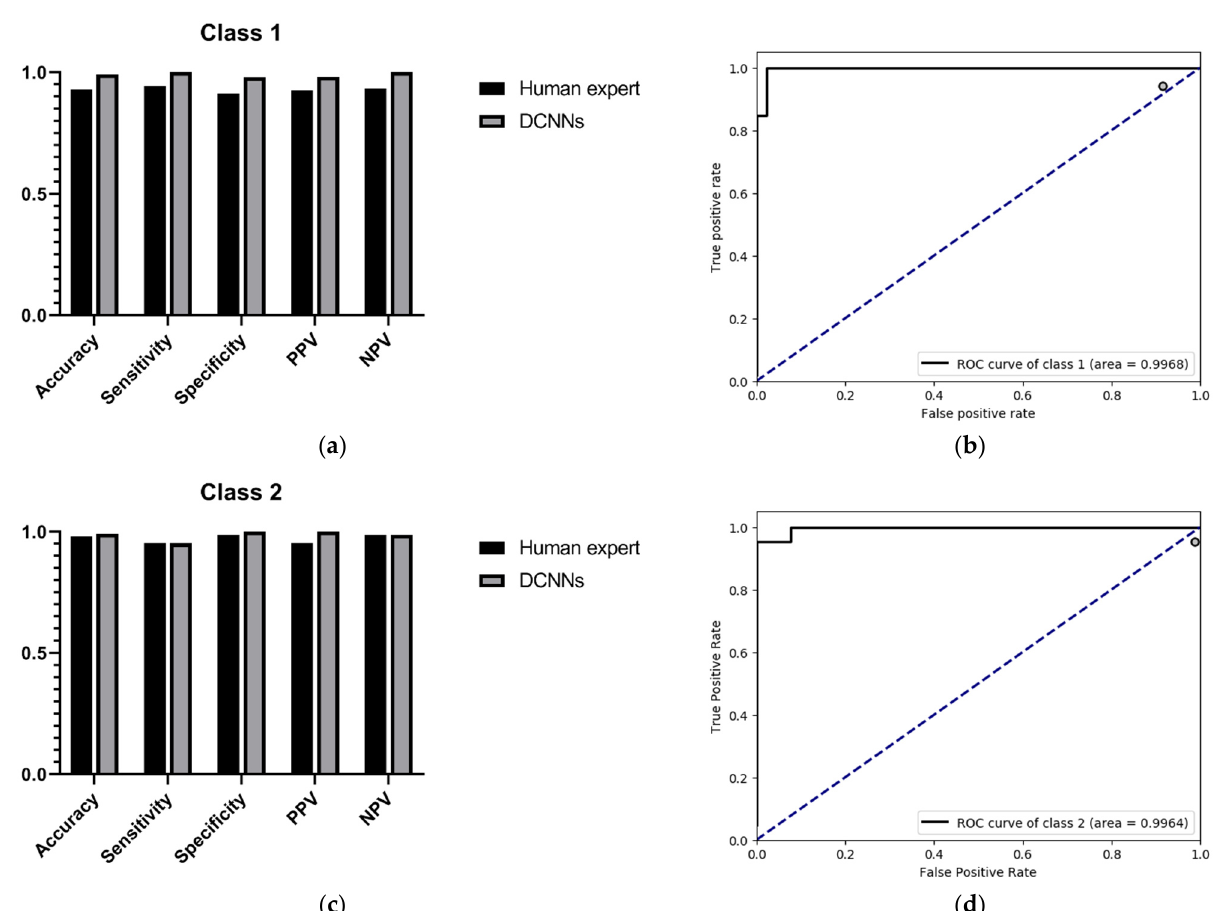
Figure 4. Evaluation results in the external validation dataset B. ( a ) Accuracy, sensitivity, specificity, PPV, NPV of the recognition of class 1; ( b ) ROC curves and AUC value of the recognition of class 1; ( c ) accuracy, sensitivity, specificity, PPV, NPV of the recognition of class 2; ( d ) ROC curves and AUC value of the recognition of Class 2.